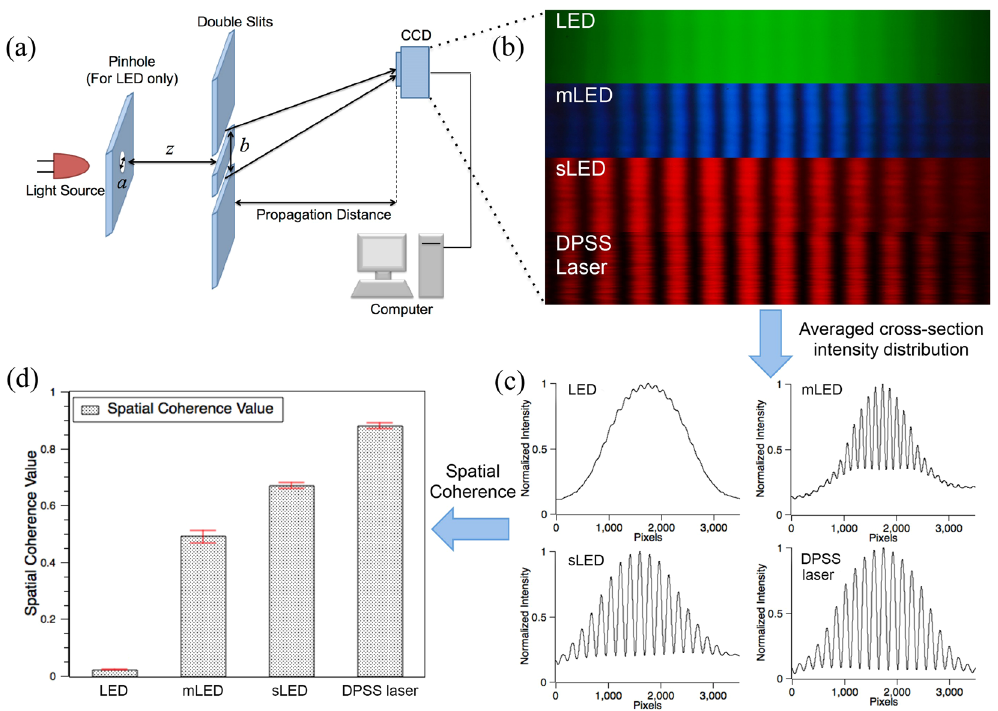
Figure 6. ( a ) Double-slits experiment setup. ( b ) From top to bottom are the interference patterns for LED, mLED, sLED and DPSS laser, their averaged cross-section intensity distributions are shown in ( c ) and their spatial coherence values are shown in ( d